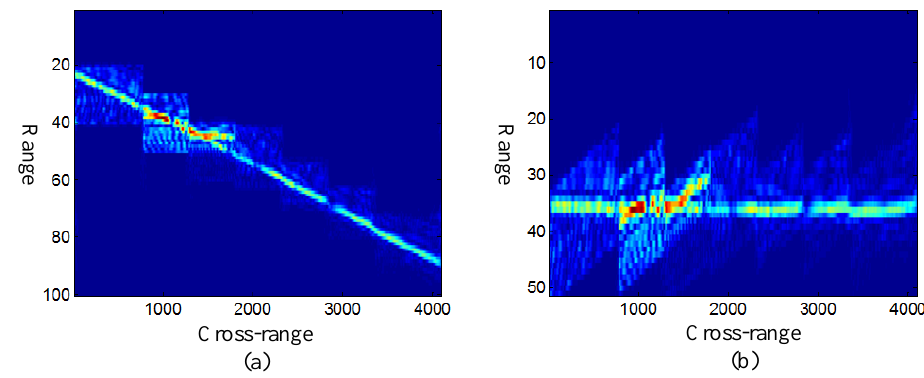
Figure 12. The envelope of T2. ( a ) Before correction. ( b ) After correction.